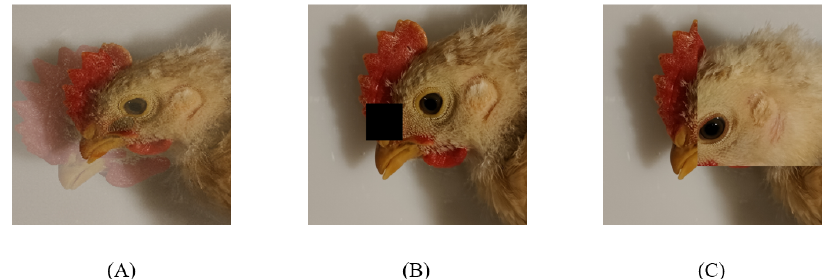
Figure 3. Illustration of different dataset augmentation methods. ( A ) Effect of using Mixup method; ( B ) Effect of using Cutout method; ( C ) Effect of using CutMix method.